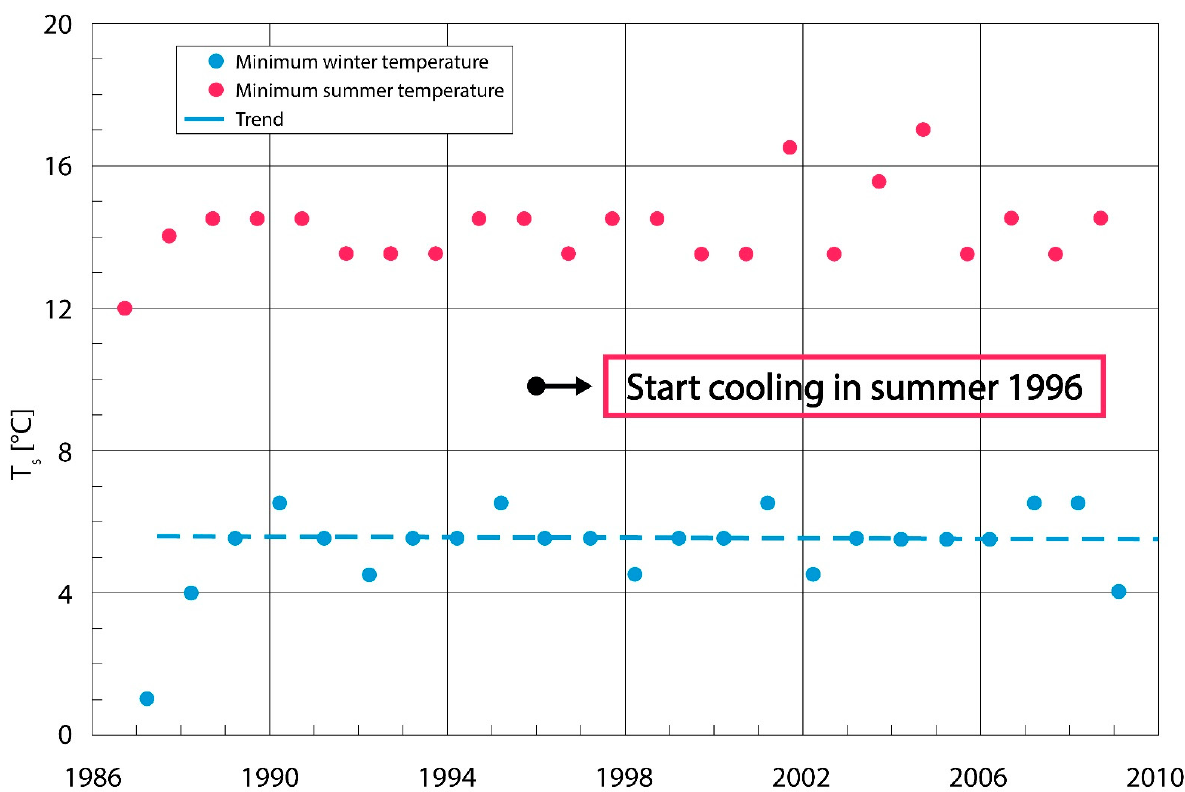
Figure 18. Stability of fluid temperatures from BFE during the time period from 1987 to 2009, for a single-family house, from data in [27]. T s : temperature of return fluid from BHE. For details, see text.